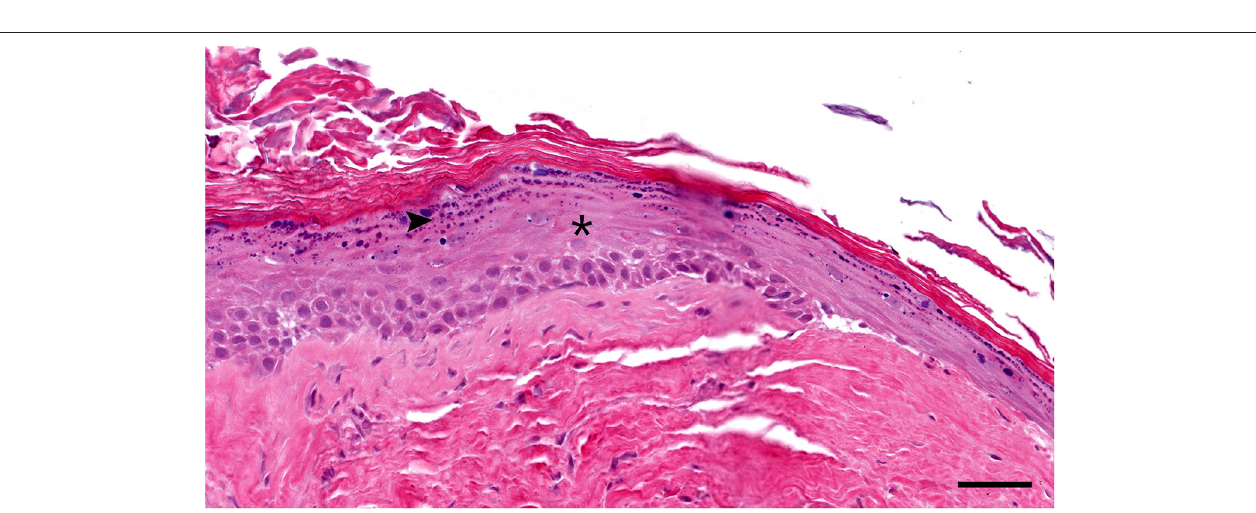
FIGURE 4 | Histopathology high magnification (20 × objective): Segment of the cyst lining. The epidermis-like stratified squamous epithelium has thickened stratum spinosum (asterisk) and stratum granulosum (arrowhead) with orthokeratotic hyperkeratosis. Note the lack of hair follicles or adnexal glands in the underlying fibrous tissue Hematoxylin and eosin stain; Bar = 50 µ